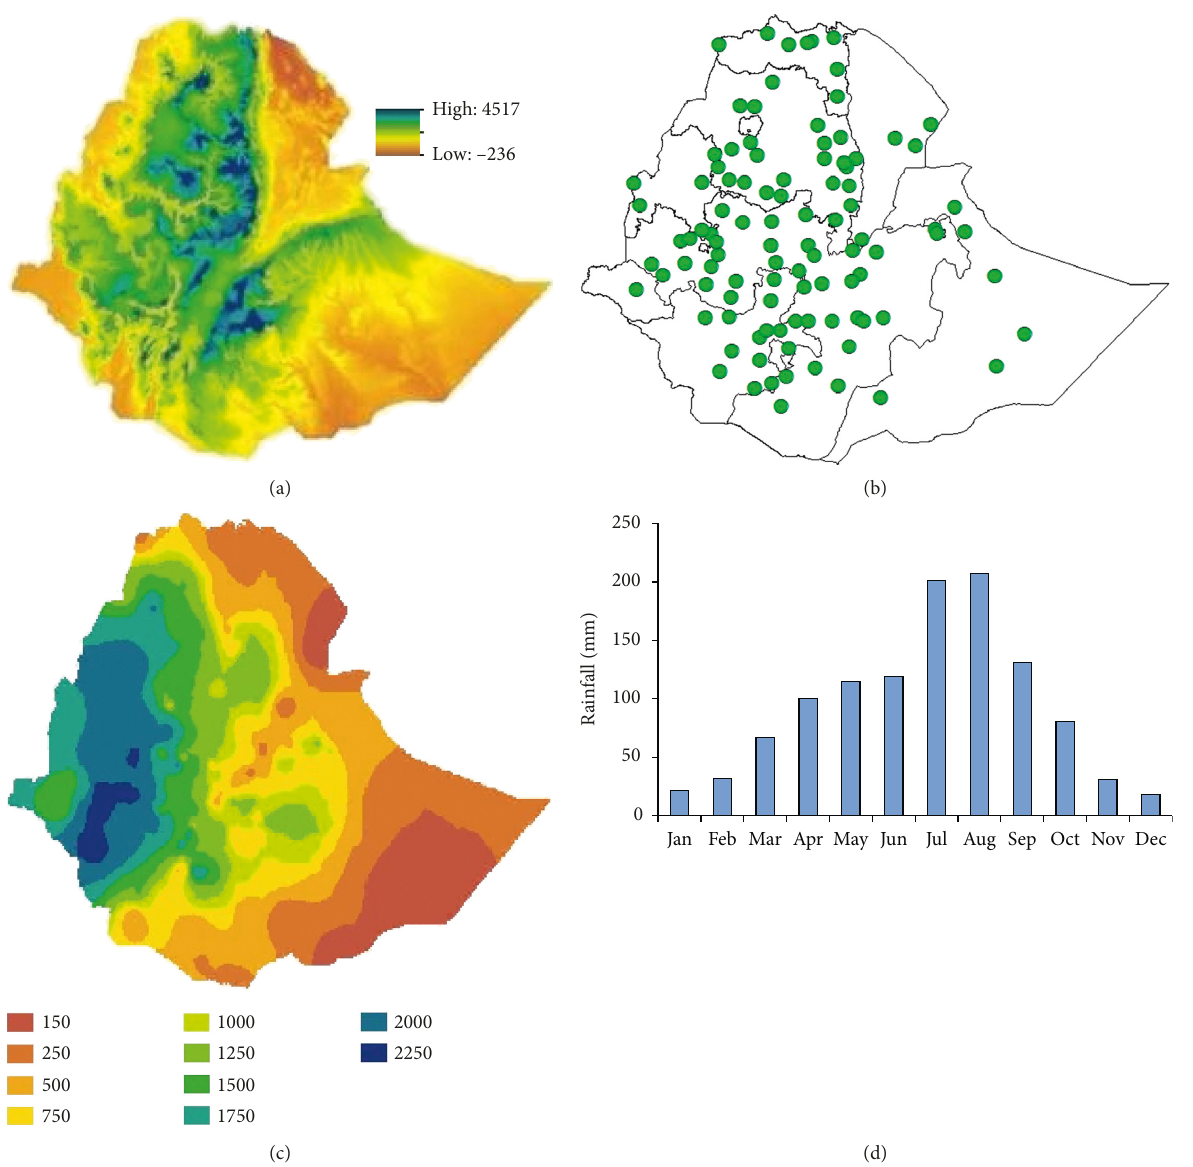
Figure 1: (a) Topographical map of Ethiopia (m). (b) Selected station distribution for this study. (c) Mean annual rainfall climatology (mm). (d) Monthly rainfall cycle